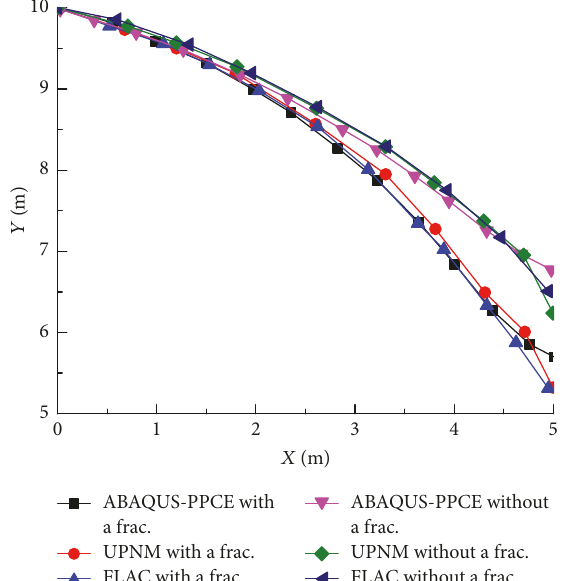
Figure 12: Comparison of the results obtained by different